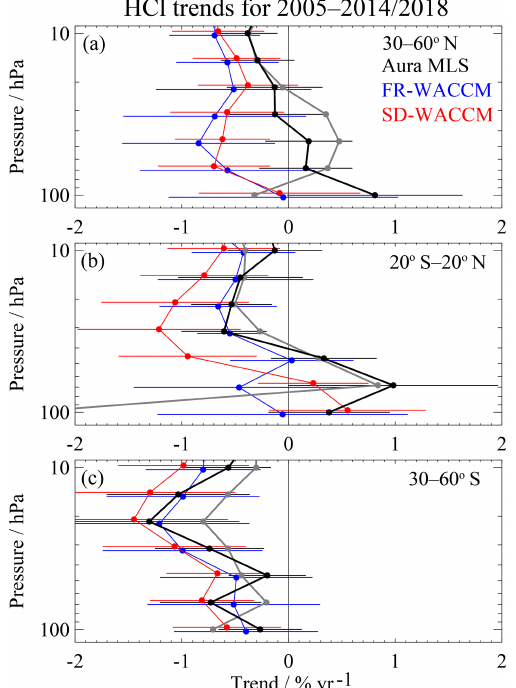
Figure 23. Same as Fig. 19 but for lower-stratospheric MLS HCl data trends for 2005–2014/2018 (with grey points showing MLS results through 2018) and WACCM HCl trends for